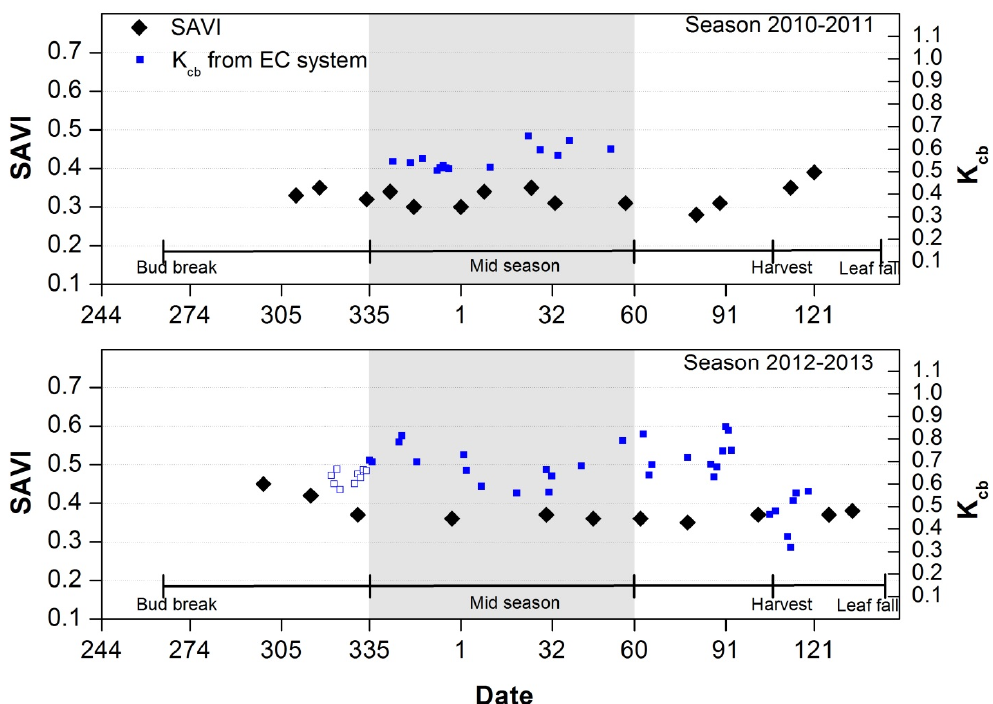
Figure 5. Evolution of the soil adjusted vegetation index (SAVI) and the basal crop coefficient from the eddy covariance system (EC) for the drip-irrigated apple orchard during the 2010–11 and 2012–13 growing seasons. Shaded areas represent the midseason growth stages. Unfilled squares represent the period with apple-weeds cover mixture.